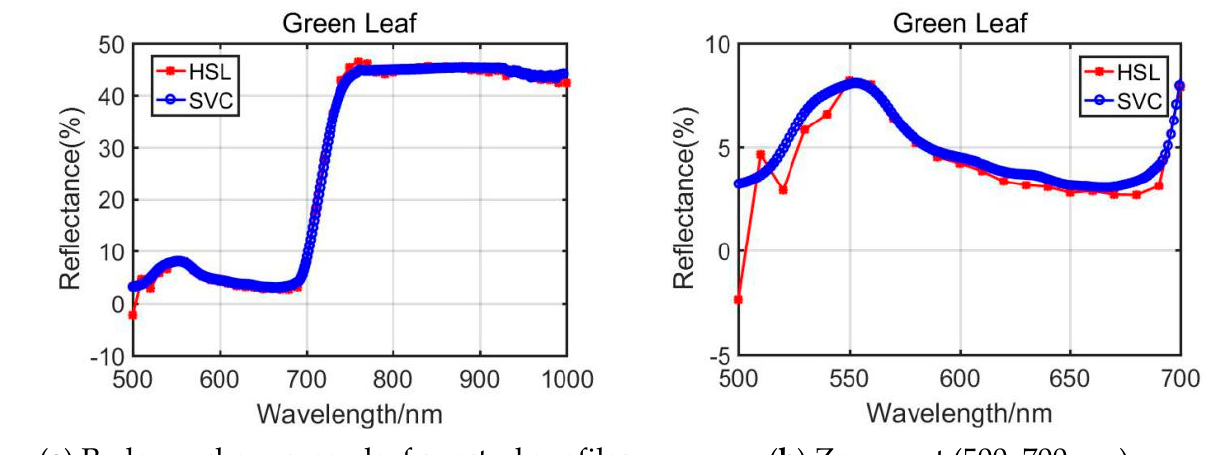
Figure 7. Radermachera green leaf spectral profiles.